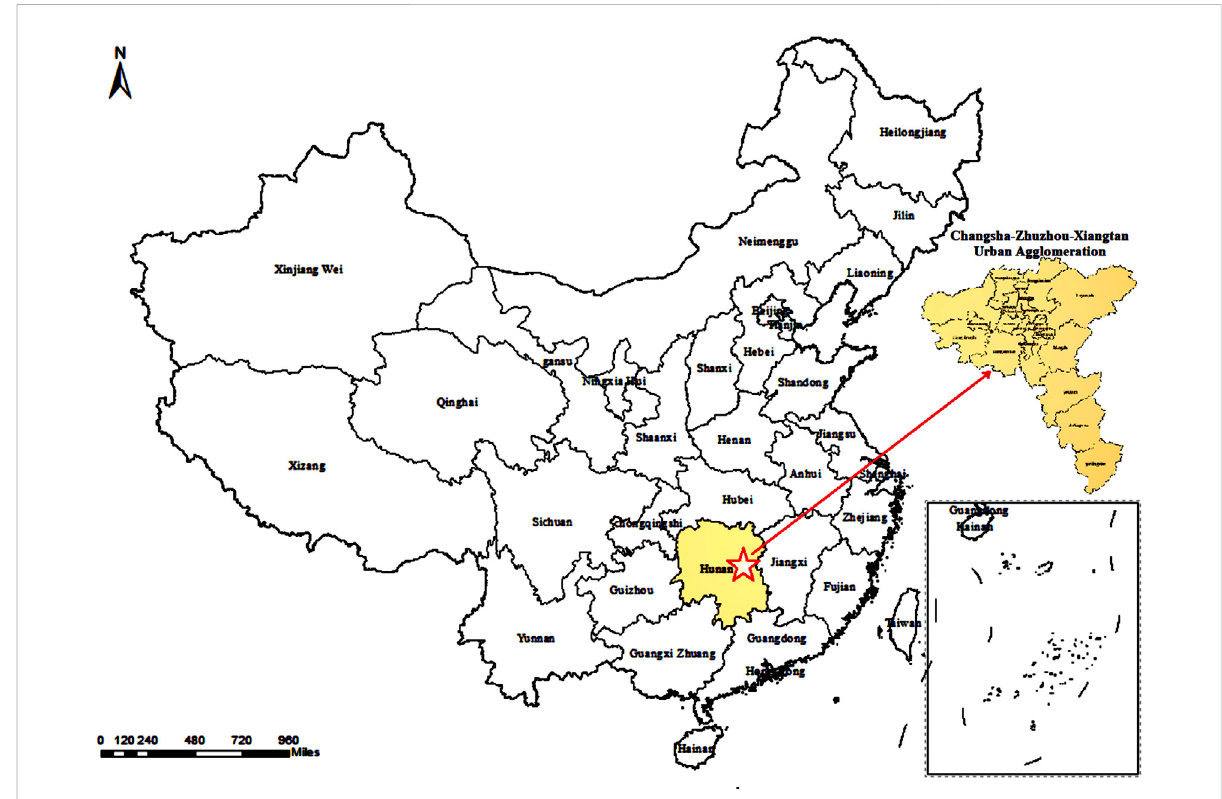
FIGURE 2 The location and scope of Changsha-Zhuzhou-Xiangtan urban